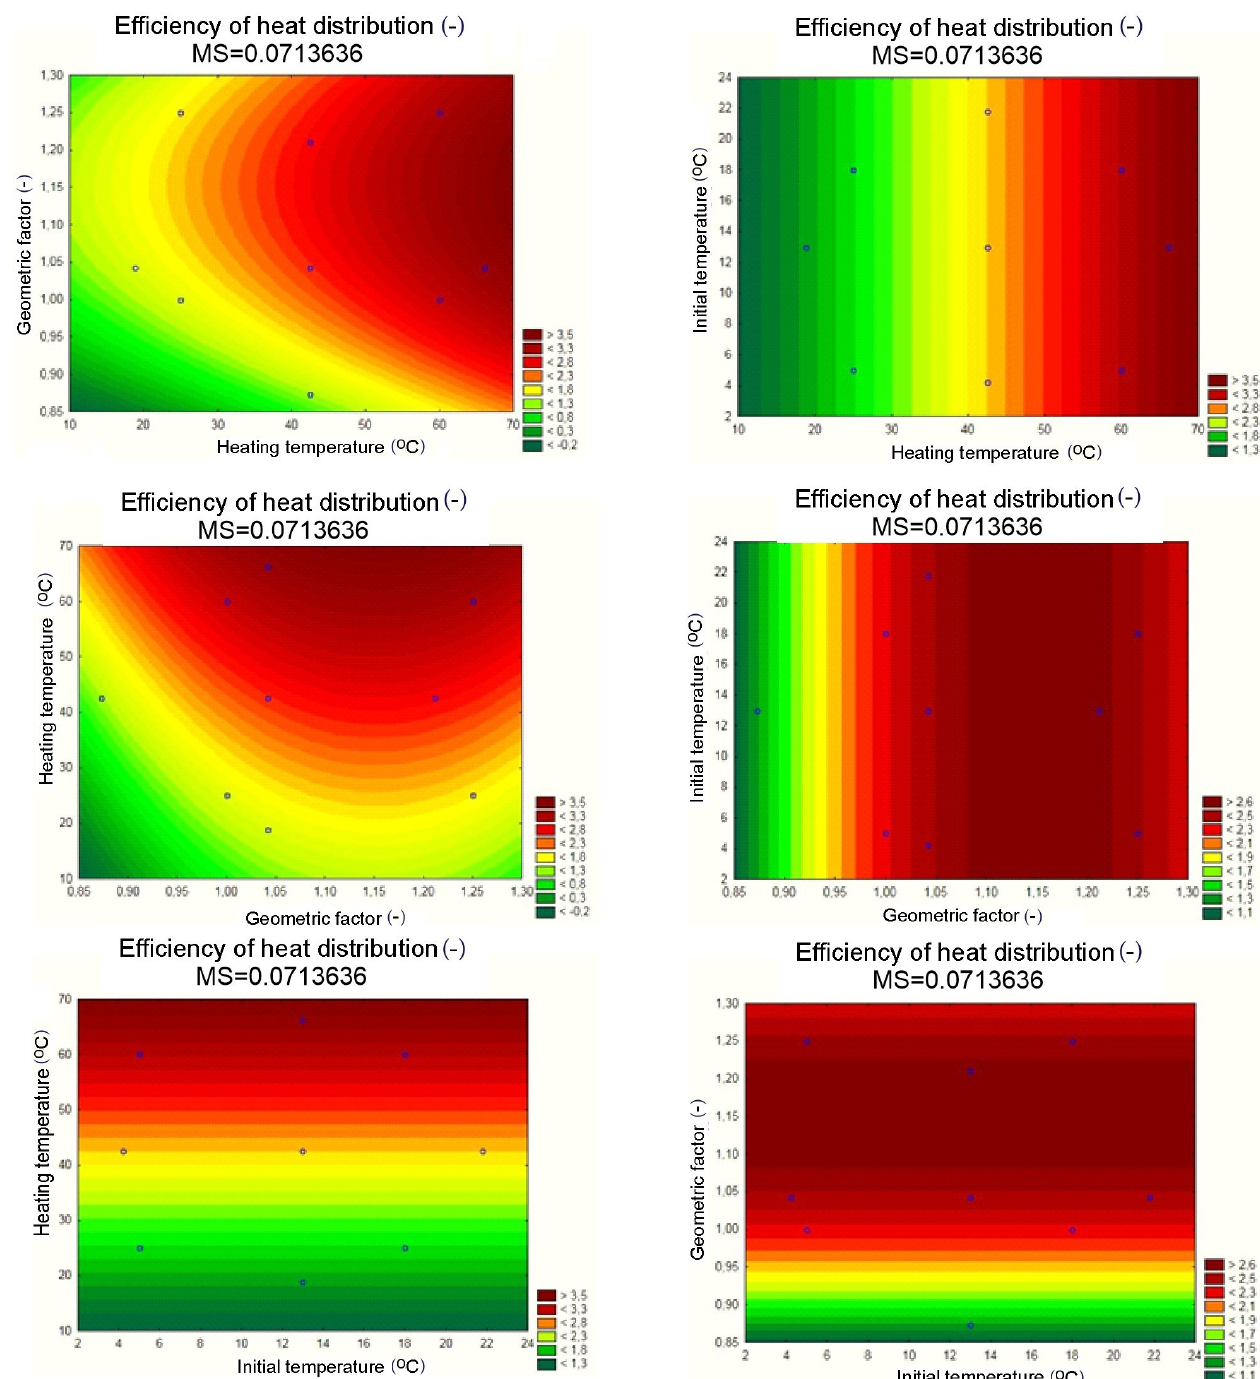
Figure 12. Response planes of the assumed polynomial approximation, presenting the impact of input quantities on the output quantity, applicable to the pure PCM heat